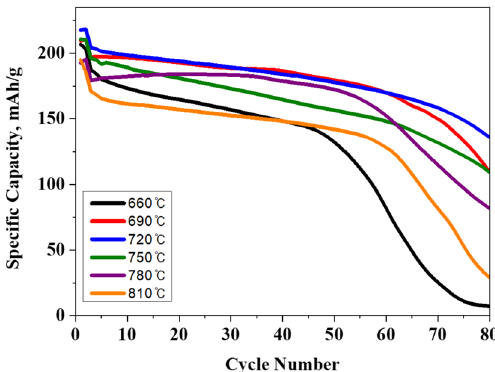
Figure 5. Cycling performances of NCA.